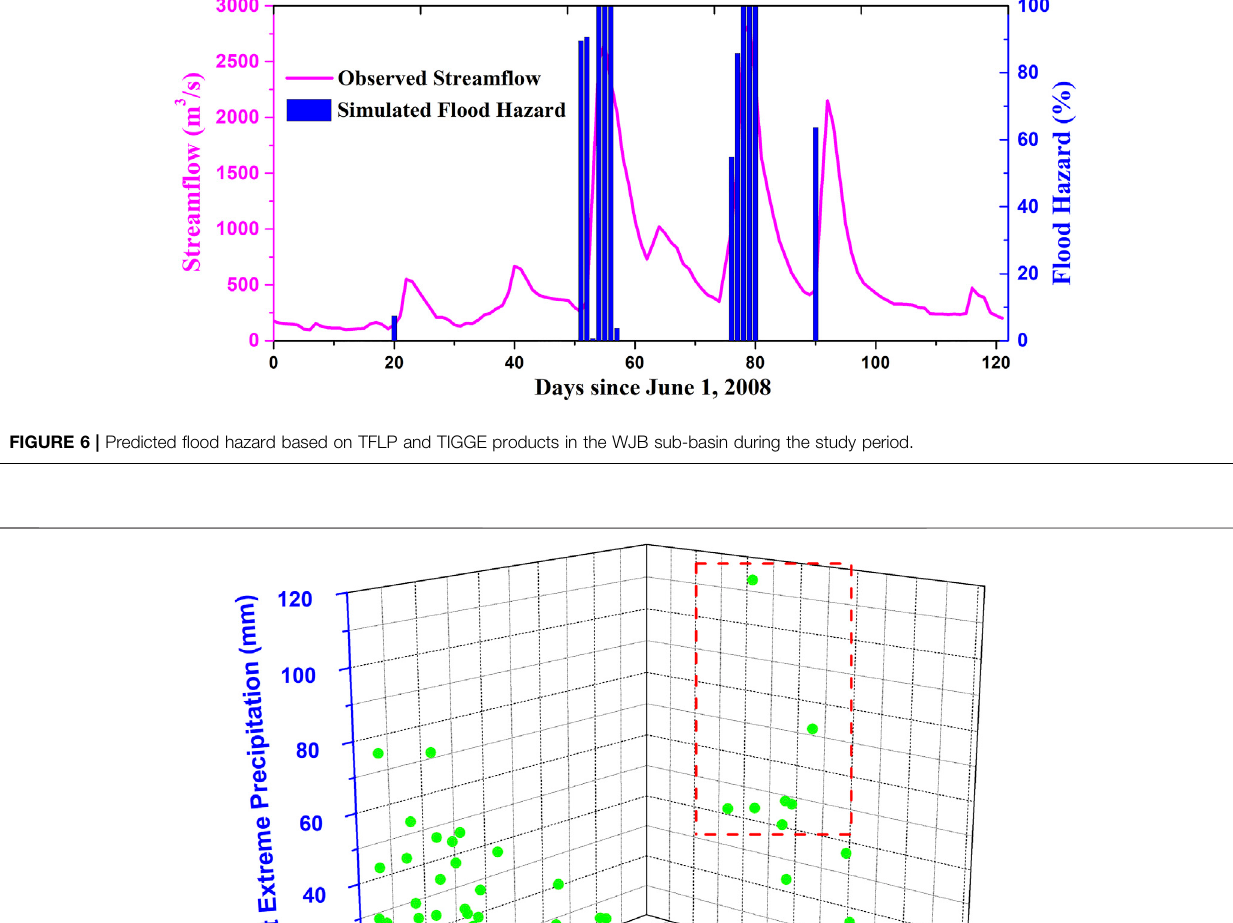
Frontiers in Earth Science |